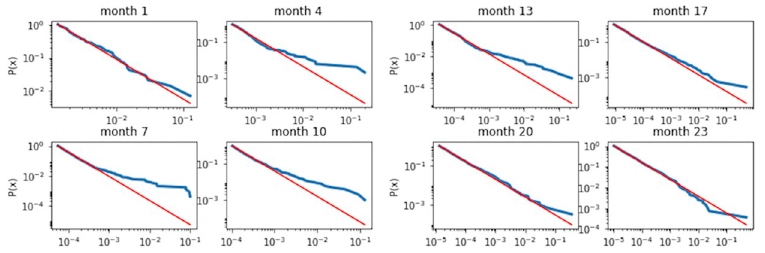
Fig 12. The fitness distributions computed for all nodes month by month in the second (stable) period of bitcoin transactions and shown in CCDF (blue line). The Red line shows the power-law function with an exponent of -2. Considering the limitation of space, we show the fitness distributions for every 3 to 4 months. It can be seen that the distribution has a power-law shape with some deviation from month 4 until month 13.